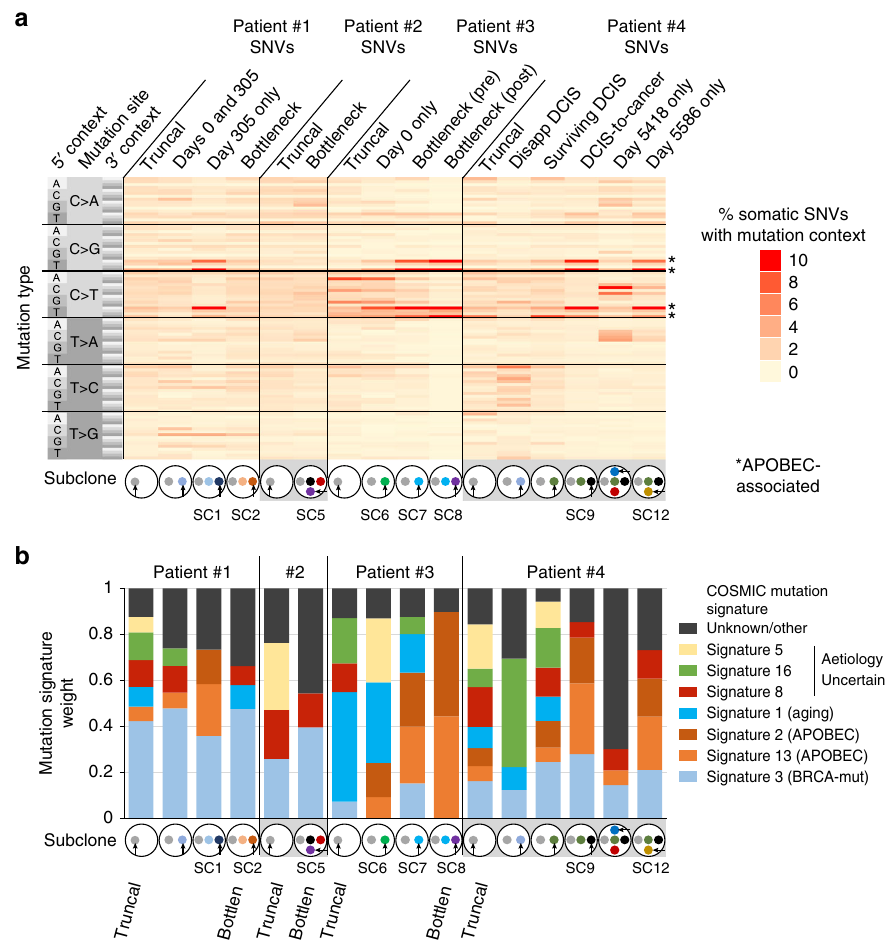
Fig. 4 Mutation signature evolution in four breast cancers. a Heatmap showing percent of SNVs in indicated subclones, de fi ned in Fig. 2, with each of 96 possible mutation/trinucleotide context combinations. b Mutation signature weights for COSMIC mutation signatures in indicated subclones. Signatures with < 0.03 average weight and mutations not accounted for by known signatures are included in the unknown/other